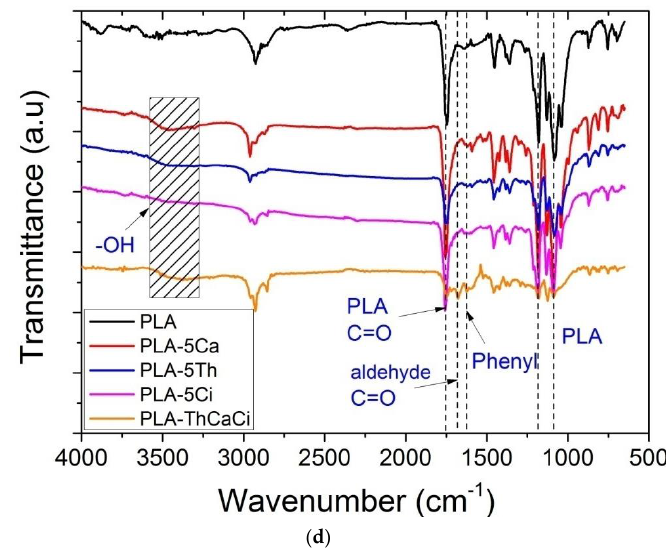
Figure 3. FTIR spectra of neat PLA and the triple blend of PLA with thymol, carvacrol and limonene, PLA-ThCaLim, together with the corresponding spectra of PLA with each of the active ingredients ( a ) of neat PLA and the triple blend of PLA with carvacrol, limonene and cinnamaldehyde, PLA-CaLimCi, together with the corresponding spectra of PLA with each of the active ingredients ( b ) of neat PLA and the triple blend of PLA with thymol, limonene and cinnamaldehyde, PLA-ThLimCi, together with the corresponding spectra of PLA with each of the active ingredients ( c ) and of neat PLA and the triple blend of PLA with thymol, carvacrol and cinnamaldehyde, PLA-ThCaCi, together with the corresponding spectra of PLA with each of the active ingredients ( d ).